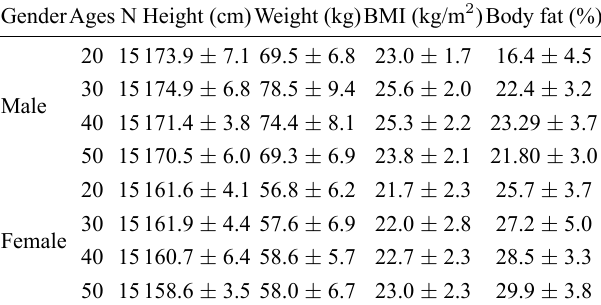
Table 1. Participant characteristics.